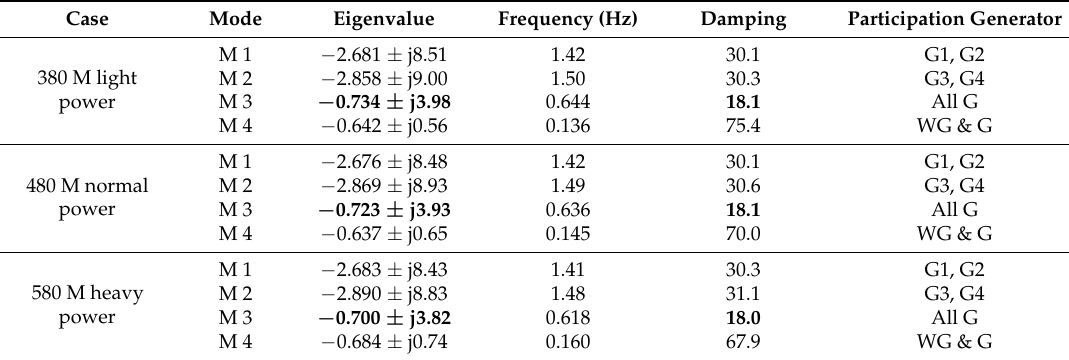
Table 4. The oscillation modes with PSSs and SVC POD.